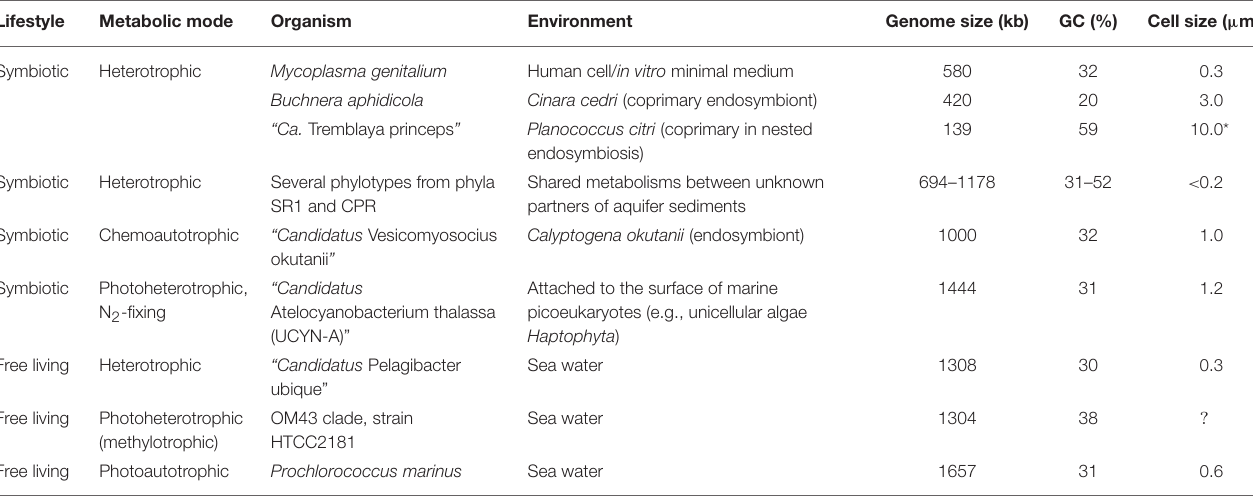
TABLE 1 | Examples of microorganisms with small genomes completely